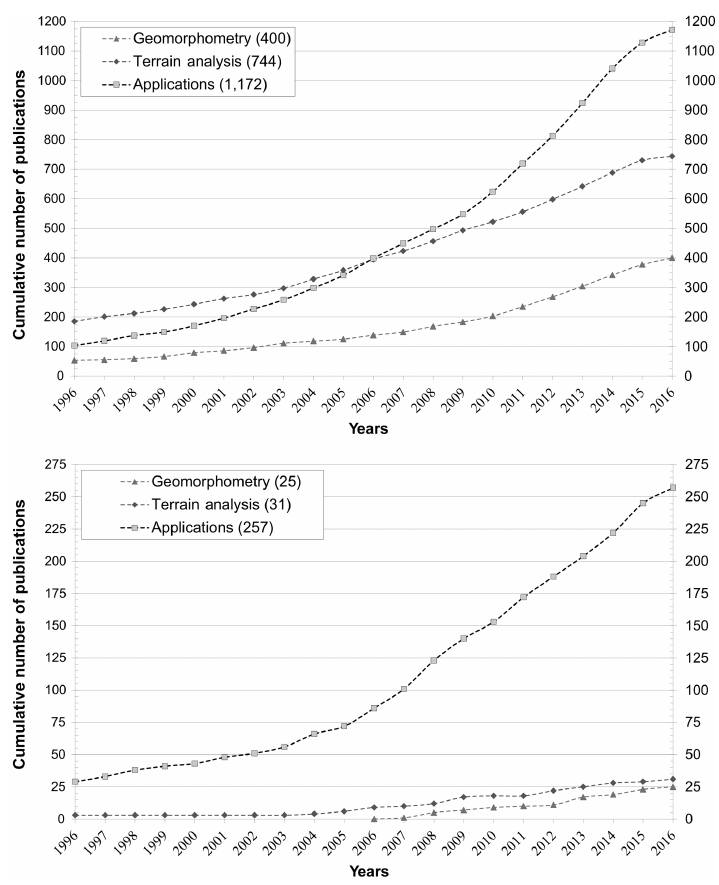
Figure 2. Cumulative number of publications (articles or reviews) listed in the Scopus database mentioning specific keywords in their title, abstract of keywords, by the end of June 2016 for land-based (top) and marine (bottom) geomorphometry publications. For the “geomor- phometry” curves, the keywords “geomorphometry” and “geomorphometric” were queried. The keyword “terrain analysis” was researched for the “terrain analysis” curves. For the terrestrial applications, the following terms were used to query the database: “topographic variables”, “topographic attributes”, “topographic derivatives”, “terrain variables”, “terrain attributes”, “terrain derivatives”, and “terrain morphology”. These terms were also used for marine applications, in addition to “bathymetric variables”, “bathymetric attributes”, “bathymetric deriva- tives”, “seafloor morphology”, and “seabed morphology”. The queries were all performed to exclude (for land-based publications) or include (for marine publications) the terms “marine”, “ocean”, and “underwater”. We note that some common terms in the field (e.g. surface pa- rameters, seafloor characterization) were not included because of their parallel use and different meaning in other fields that do not involve